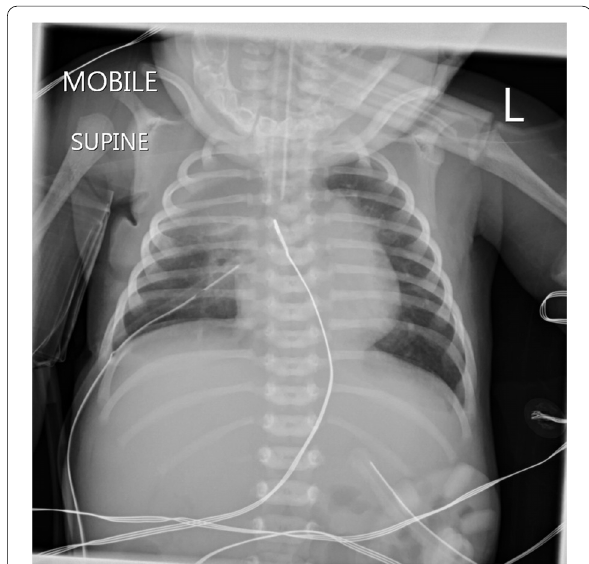
Fig. 3 Post-operative chest X-ray showing improvement in lung expansion and a chest drain in